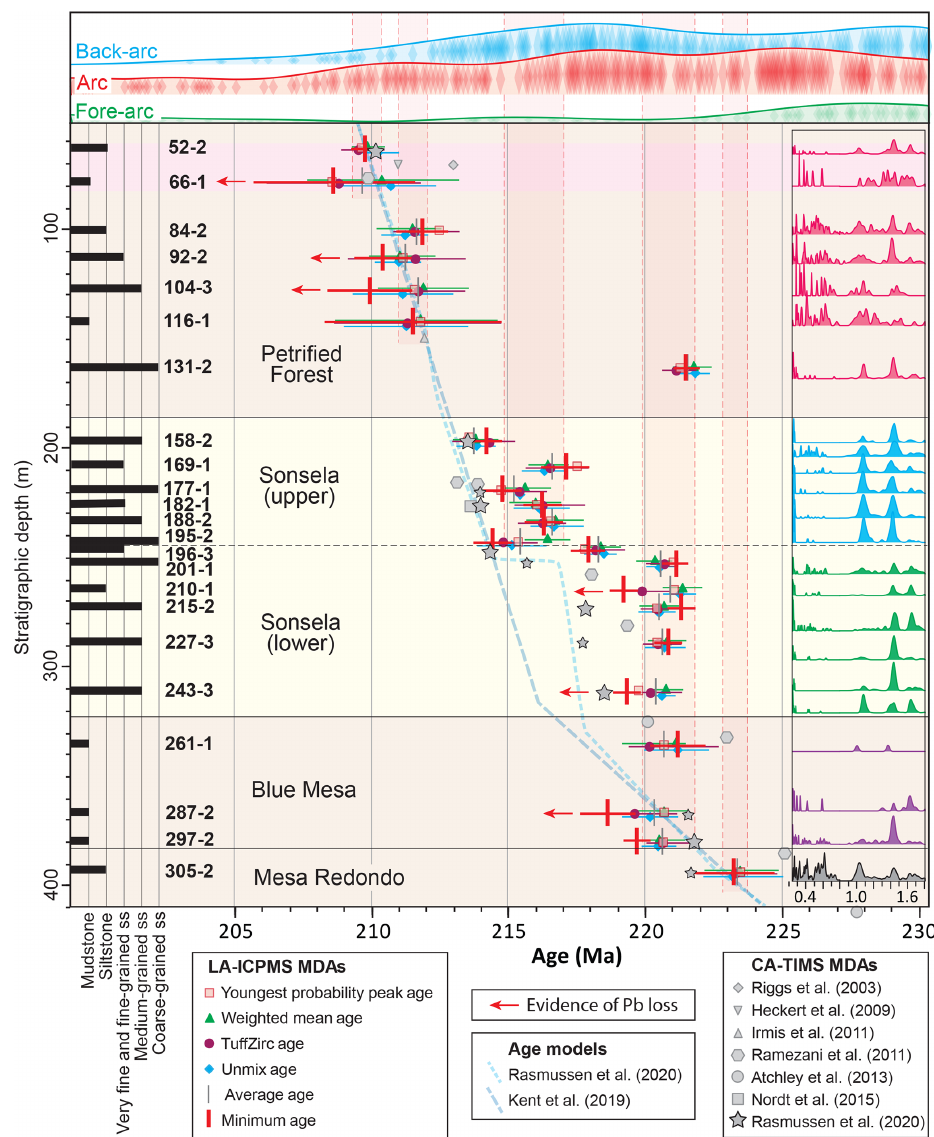
Figure 13. Plot showing the available chronologic information for strata of the Chinle Formation from the study area. LA-ICPMS results are shown using red crosses for interpreted maximum depositional ages (using the minimum age approach of Vermeesch, 2020), and various symbols for the four age estimates (and the average) of the youngest cluster. Red arrows indicate that LA-ICPMS ages may be compromised by Pb loss (Table S6). CA-TIMS and ID-TIMS ages are shown in approximate stratigraphic position (as shown by Kent et al., 2019), with outcrop samples in gray symbols and core samples using black symbols. Smaller symbols represent ID-TIMS ages or CA-TIMS ages based on a single age or of uncertain reliability. Stratigraphic units are keyed to dominant rock type, with brown indicating mudstone and siltstone, yellow indicating sandstone, and pink indicating bentonite. The average grain size of each sample is shown with bars on the left (from Sect. S1 and Table S1). PDP curves to the right show 2.0Ga to 240Ma ages, as plotted in Fig. 7. Also shown are age models of Kent et al. (2019) and Rasmussen et al. (2020). Vertical red bands show interpreted ages of main clusters of LA-ICPMS ages. Curves across the top of the diagram show the distribution of ages from (1) fore-arc strata of the Barranca and El Antimonio groups in Sonora (Gonzalez-Leon et al., 2009; Gehrels and Pecha, 2014) and the Great Valley Group in California (DeGraaff-Surpless et al., 2002; Surpless et al., 2006; Wright and Wyld, 2007), (2) Permian–Triassic igneous rocks in California (Chen and Moore, 1982; Miller at al., 1995; Tobisch et al., 2000; Barth and Wooden, 2006; Barth et al., 2011, 2013; Saleeby and Dunne, 2015), and (3) strata of the Chinle Formation in other parts of the Colorado Plateau (Dickinson and Gehrels, 2008; Riggs et al., 2012; Marsh et al., 2019). Diamond-shaped symbols beneath curves represent individual